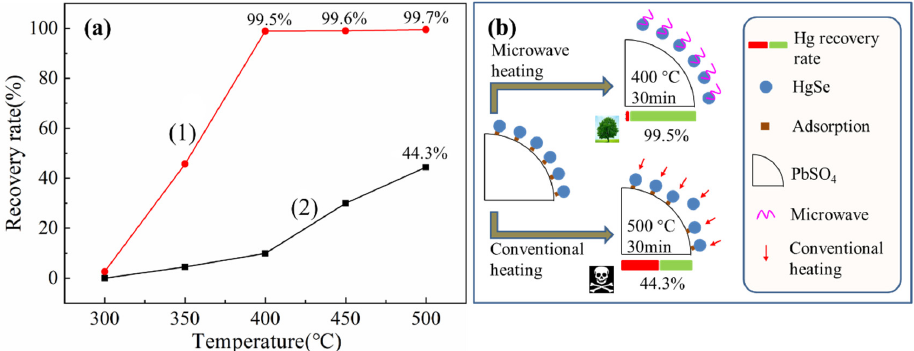
Figure 8. ( a ) Recovery rate of mercury by ( a 1) microwave heating, ( a 2) by conventional heating, and the ( b ) enhanced desorption mechanism diagram by microwave selective heating.